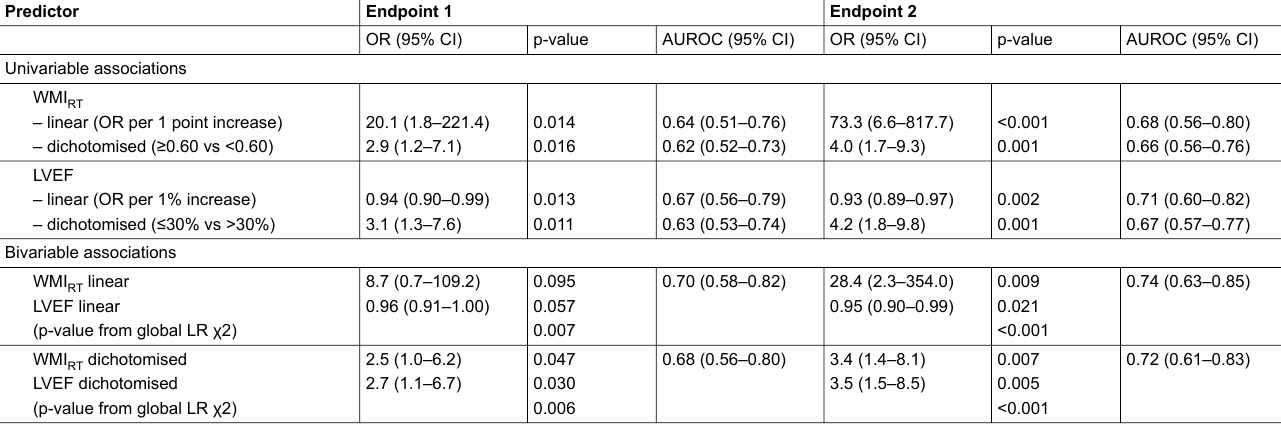
Table 2: Uni- and bi-variable associations of predictors with endpoint 1 (SCD or sustained VT/VF terminated appropriately by ICD) and endpoint 2 (any cardiac death or sustained VT/VF terminated appropriately by ICD) using logistic regression and postestimation of the area under the receiver operating characteristic curve (AUROC). Each predictor was assessed as linear measure and after dichotomisation at standard cut